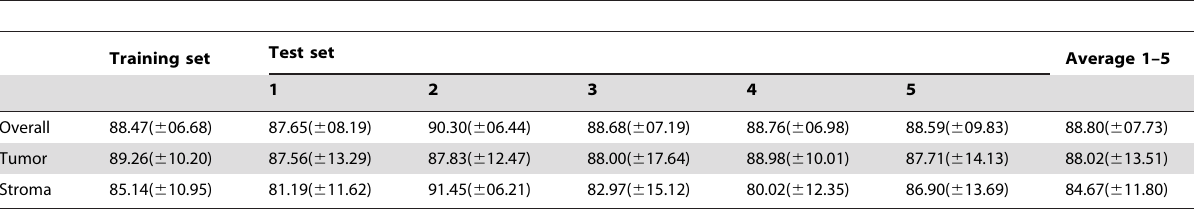
Table 4. The average classification